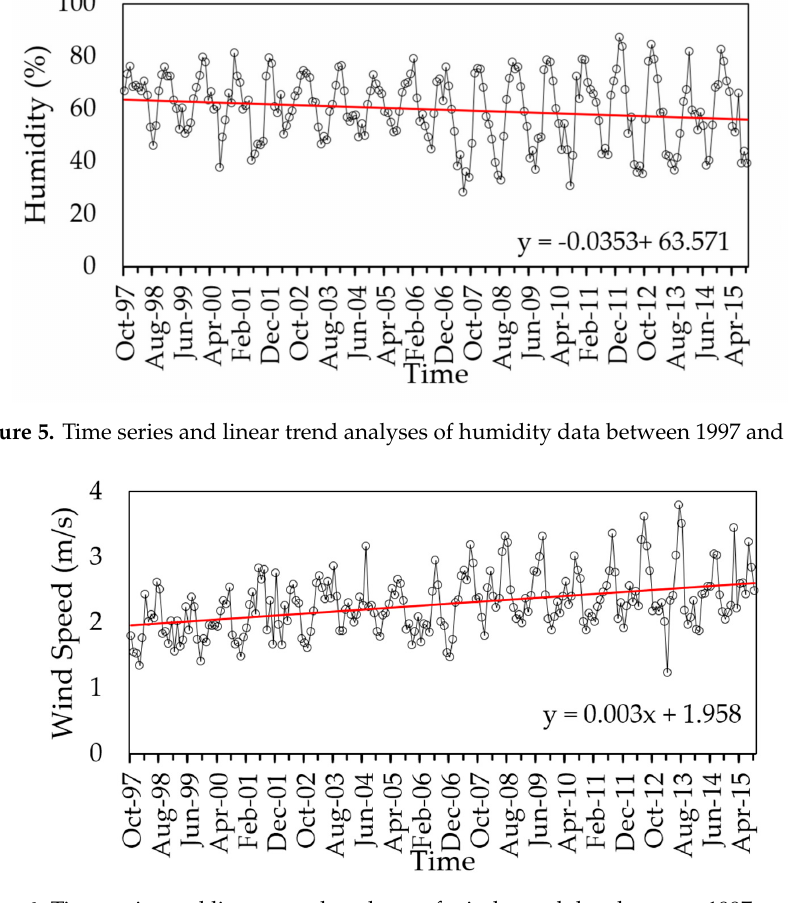
Figure 6. Time series and linear trend analyses of wind speed data between 1997 and 2015.